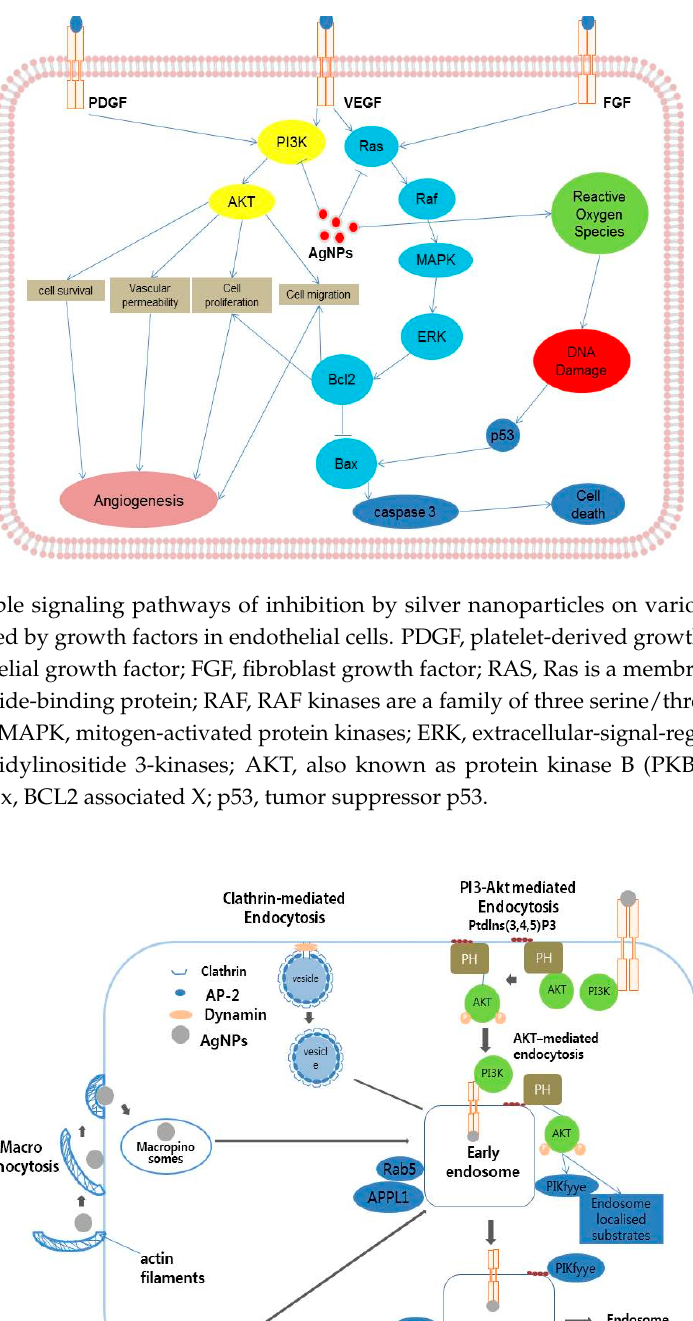
endocytosis (Figure 4).